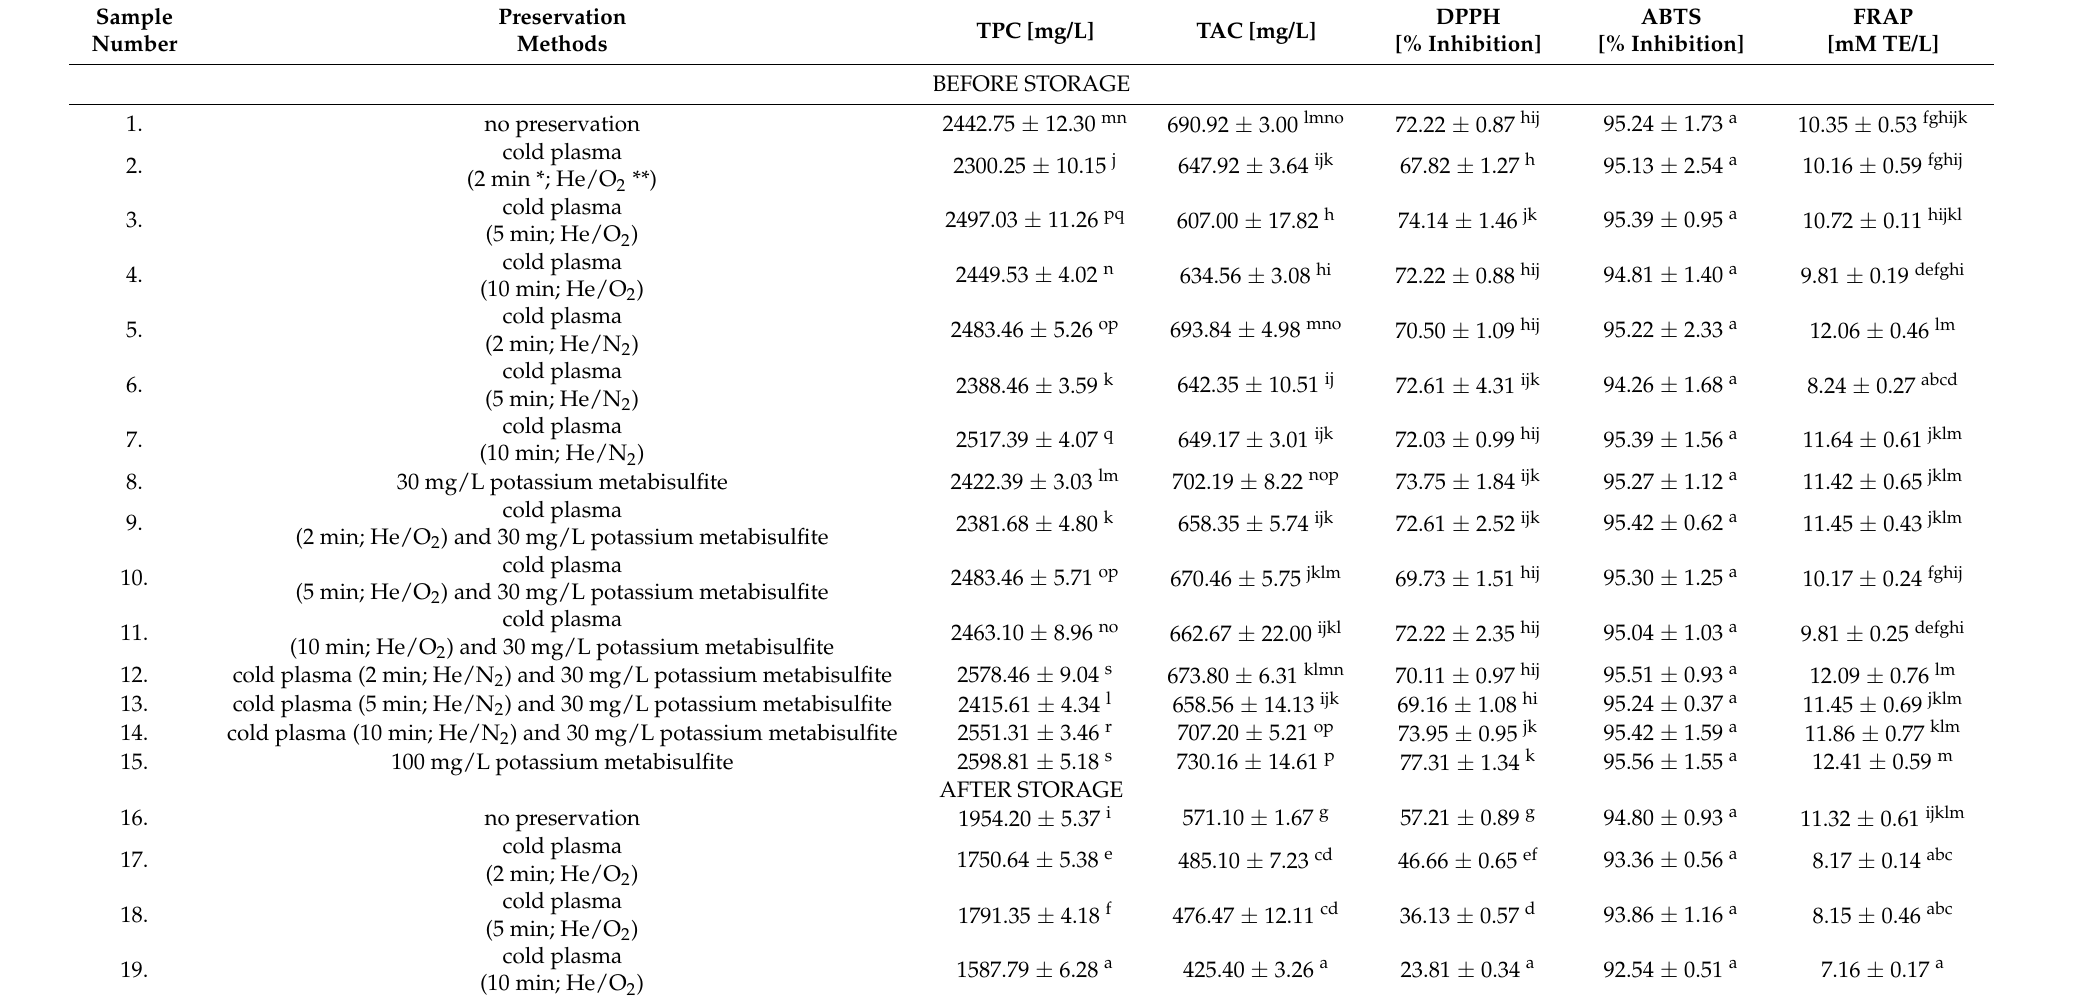
Table 2. Effect of different preservation processes and storage time on polyphenolic content and antioxidant activity of red